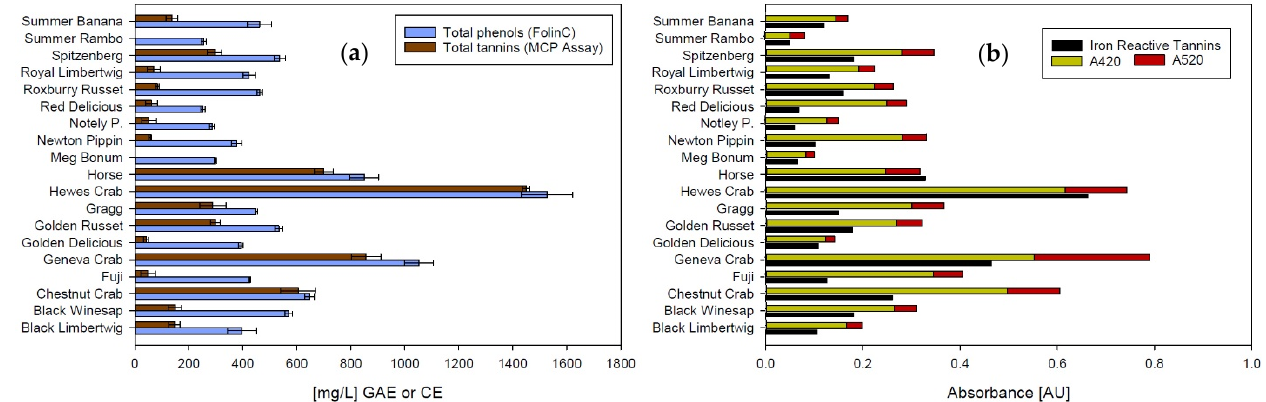
Figure 2. Analyses of phenolic material in apple ciders. ( a ) Total phenolics and total tannins, ( b ) iron reactive tannins and total color (GAE: Gallic acid equivalents; CE: Catechin equivalents). Total color is shown as the sum of absorbance values at 420 nm (yellow) and 520 nm (red). Error bars represent analytical standard deviation.